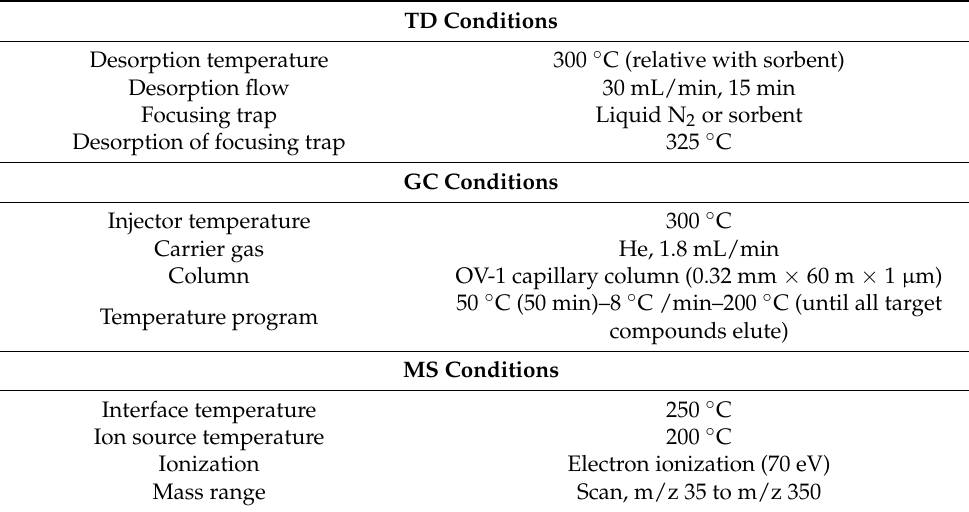
Table 2. Gas chromatography (GC), mass spectrometry (MS), and thermal desorption (TD) analy- ses conditions.